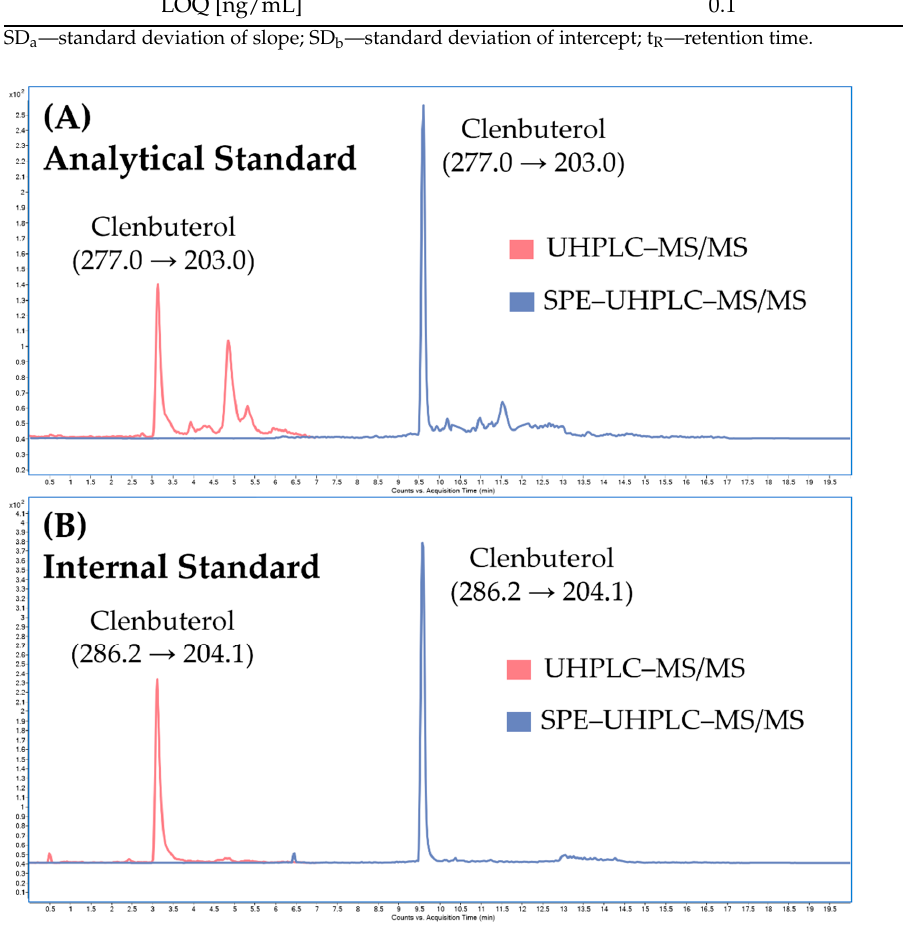
Figure 7. Illustrative chromatograms obtained from analysis of ( A ) the analytical standard of clenbuterol and ( B ) the internal standard (clenbuterol-d 9 ) spiked in the pooled urine at the LOQ concentration level (0.1 ng/mL) under UHPLC–MS/MS conditions (without online-SPE), and SPE–UHPLC–MS/MS conditions.